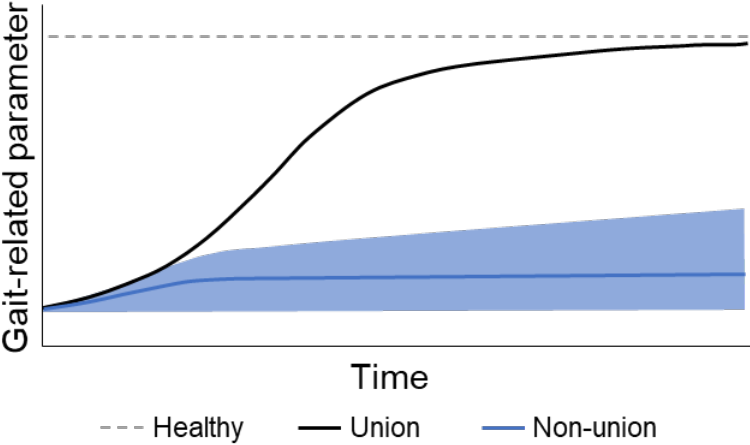
Figure 4. The expected changes in gait-related parameters after surgery in union and non-union of lower leg fractures. An increase indicates an improvement. The shaded blue indicates the expected range for non-union fractures.